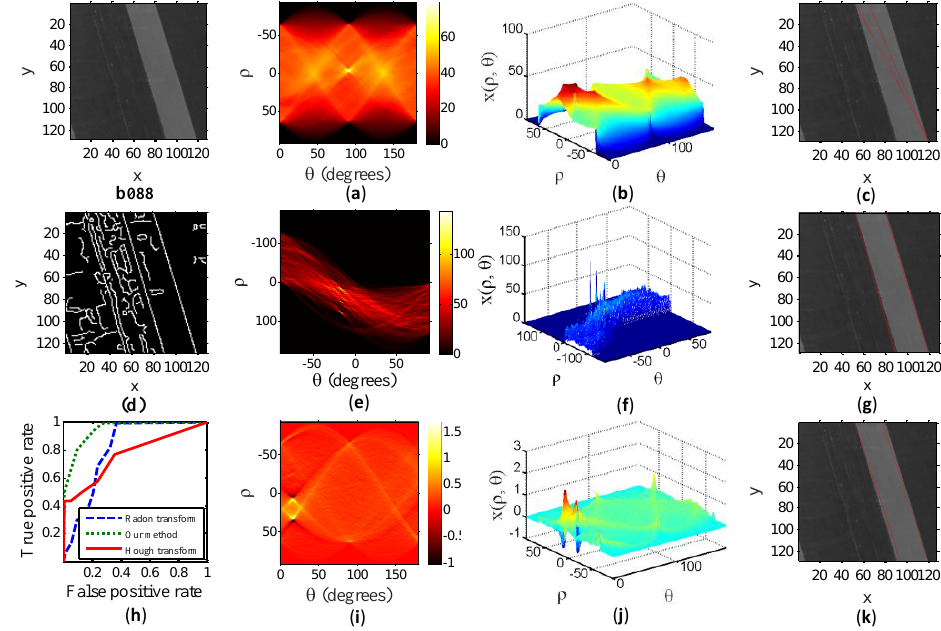
Figure 6. b088 is a test image. ( a ) Radon transform of test image in two-dimensional parameter space. ( b ) Three-dimensional form of ( a ). ( c ) Detected line from ( b ) overlaid on test image. ( d ) Binary image of the test image. ( e ) Hough transform of ( d ). ( f ) Three-dimensional form of ( e ). ( g ) Detected line from ( f ). ( h ) Receiver Operator Curves of the evaluated detection methods. ( i ) Transform image obtained by our method. ( j ) Three-dimensional form of ( i ). ( k ) Detected line from ( j